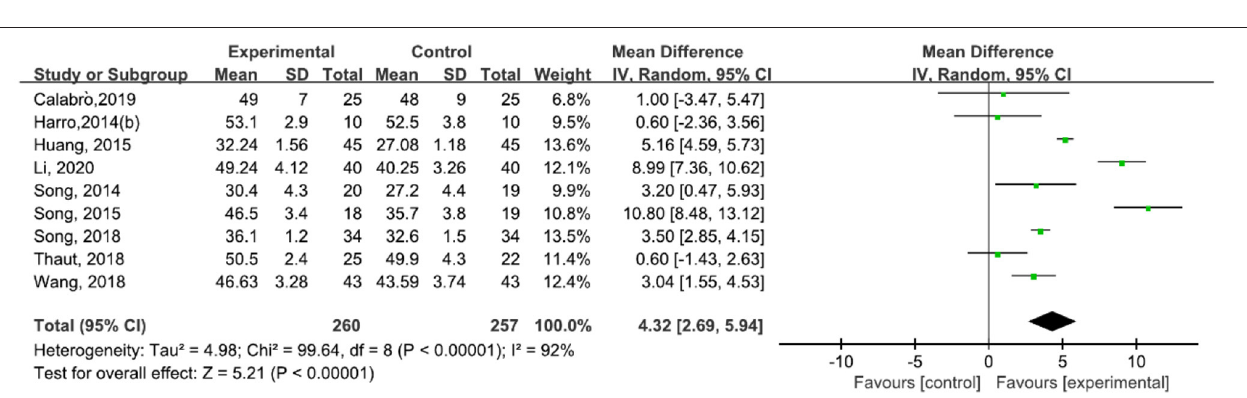
Entrainment (EE—based on an External Cueing